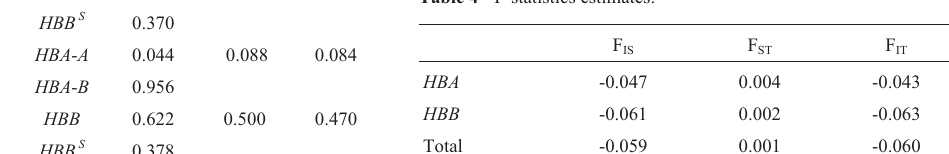
Table 4 - F-statistics